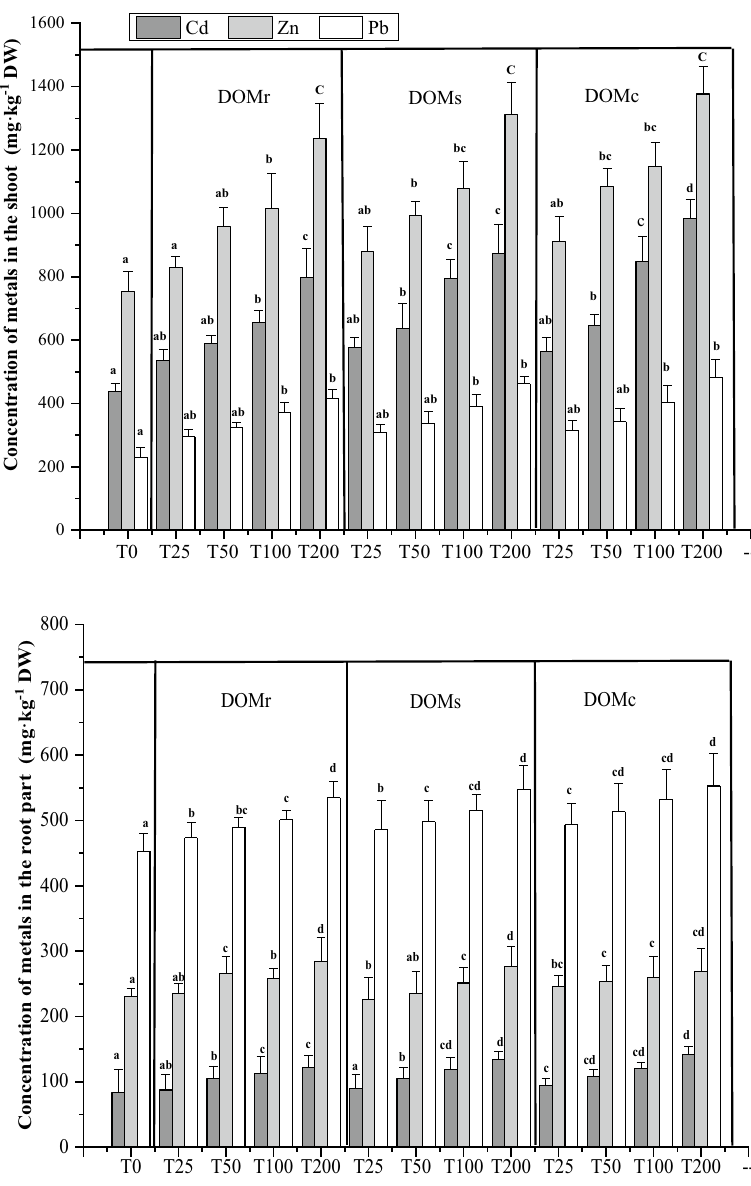
Figure 3. Concentration of Cd, Zn and Pb in the shoot and root of S. alfredii . *The lowercase letters refer to significant difference among the treatments for the same HM at 0.05